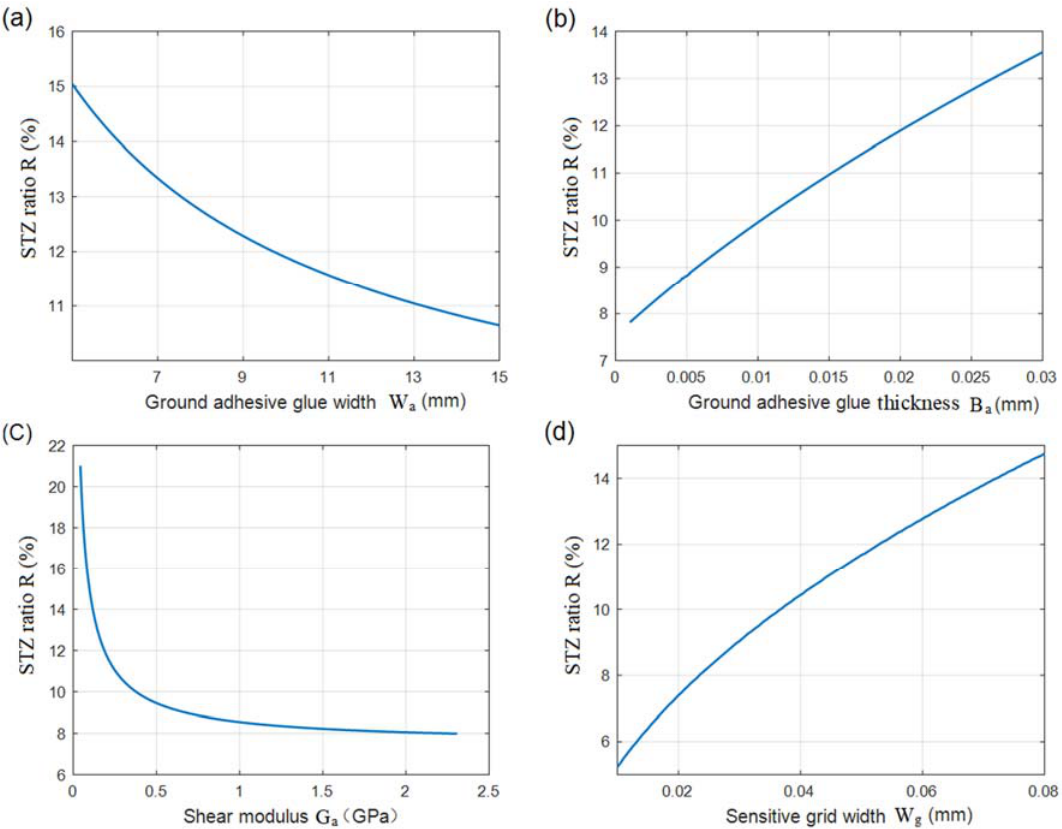
Figure 4. The ratios of strain transitional zone, which implies the axial strain distribution within sensitive grids, are determined by the structural parameters of the ground adhesive glue and the sensitive grid, including ( a ) ground adhesive glue width, ( b ) ground adhesive glue thickness, ( c ) shear modulus, and ( d ) the sensitive grid width.